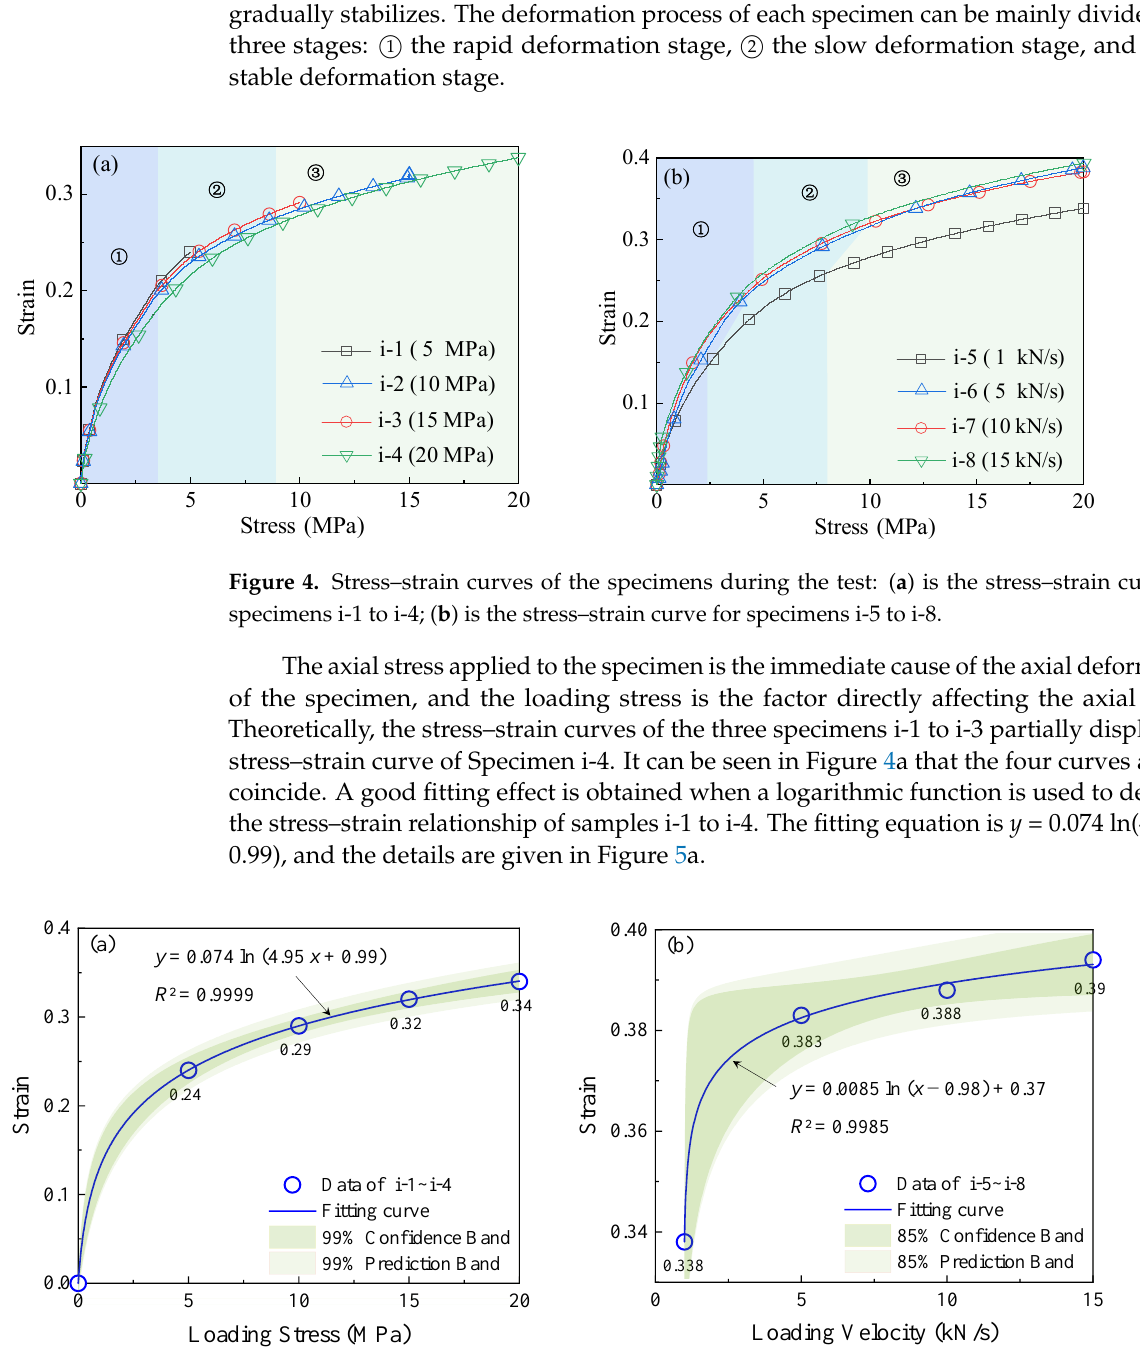
Figure 5. Fitting curves between the main control factors and strain: ( a ) is the fitted curve of loading stress with strain for specimens i-1 to i-4; ( b ) is the fitted curve of loading velocity with strain for specimens i-5 to i-8.